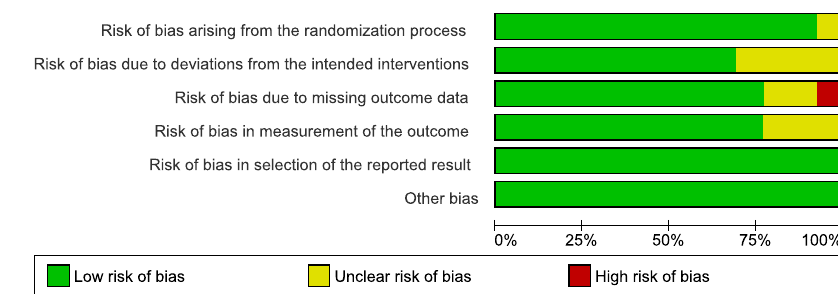
Fig. 1 Risk of bias summary. Reviewers ’ judgments about each risk of bias item for each included